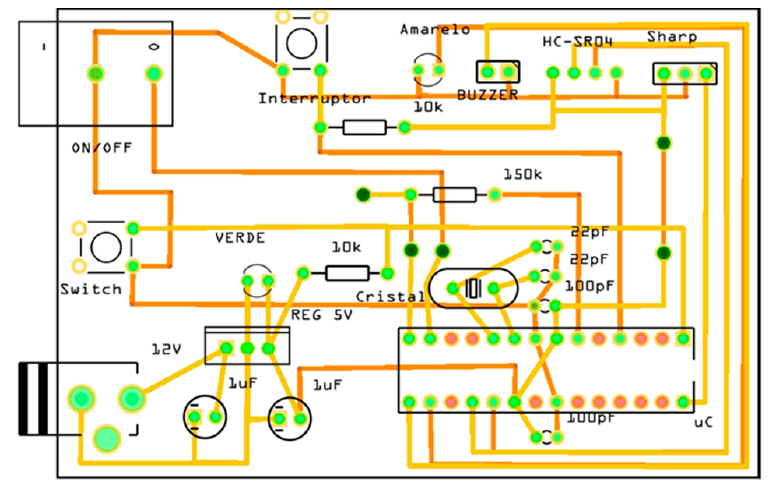
Figure 4. NoSleep prototype PCB.